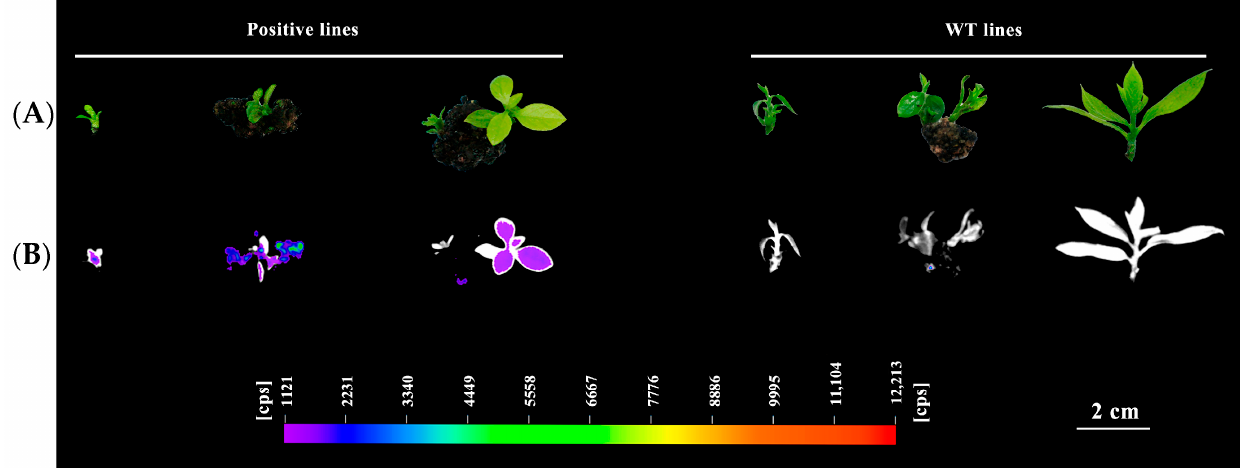
Figure 3. Detection of GFP fluorescence in a transgenic ‘Gongcheng Shuishi’ persimmon plantlet with the GFP gene. ( A ) Morphology of transgene-positive and control plants from the small to large stages. ( B ) Visualization of the GFP fluorescence signal in the transgenic plantlet by an in vivo imaging system (LB 985 Night SHADE). Bar = 2.0